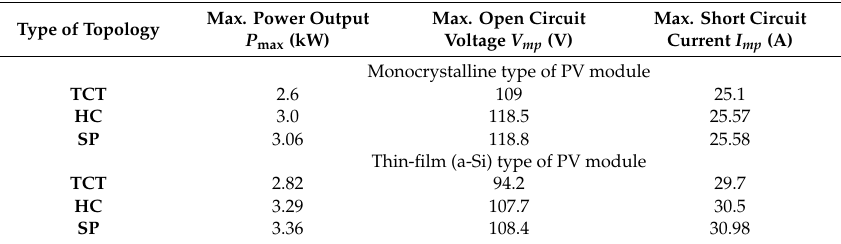
Table 7. Parameters of PV model for short-circuit fault (F2).